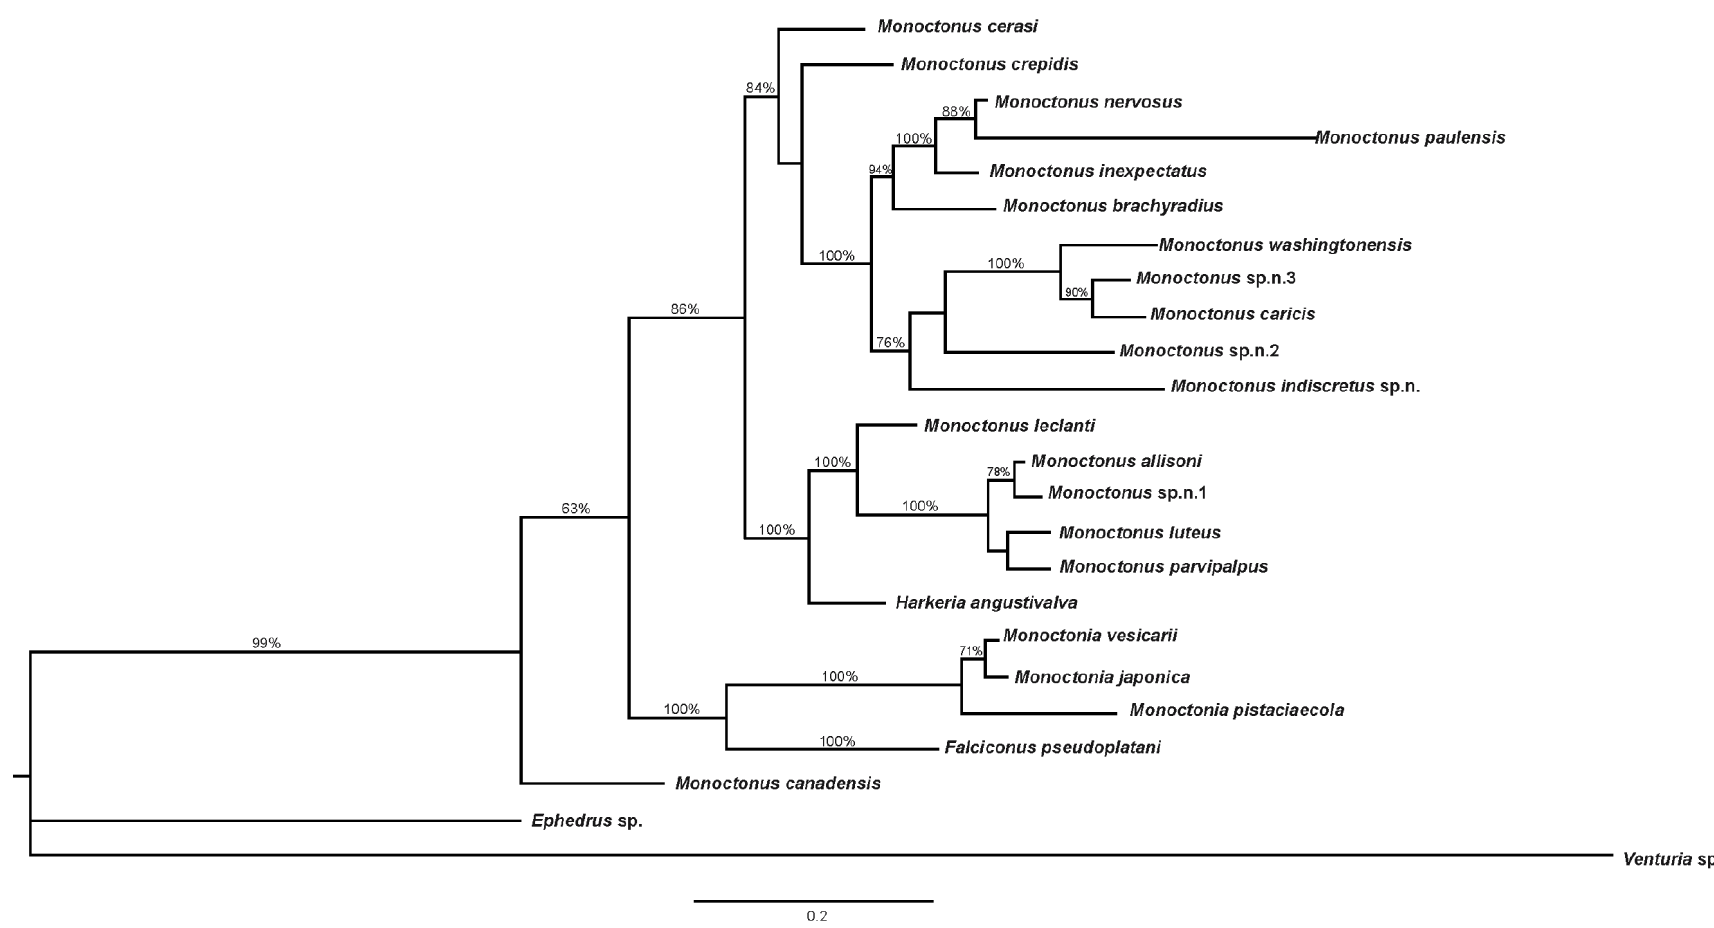
Figure 6. Phylogenetic tree based on COI , 28S rDNA and coded morphological characters. Bayesian posterior probabilities are shown above branches.